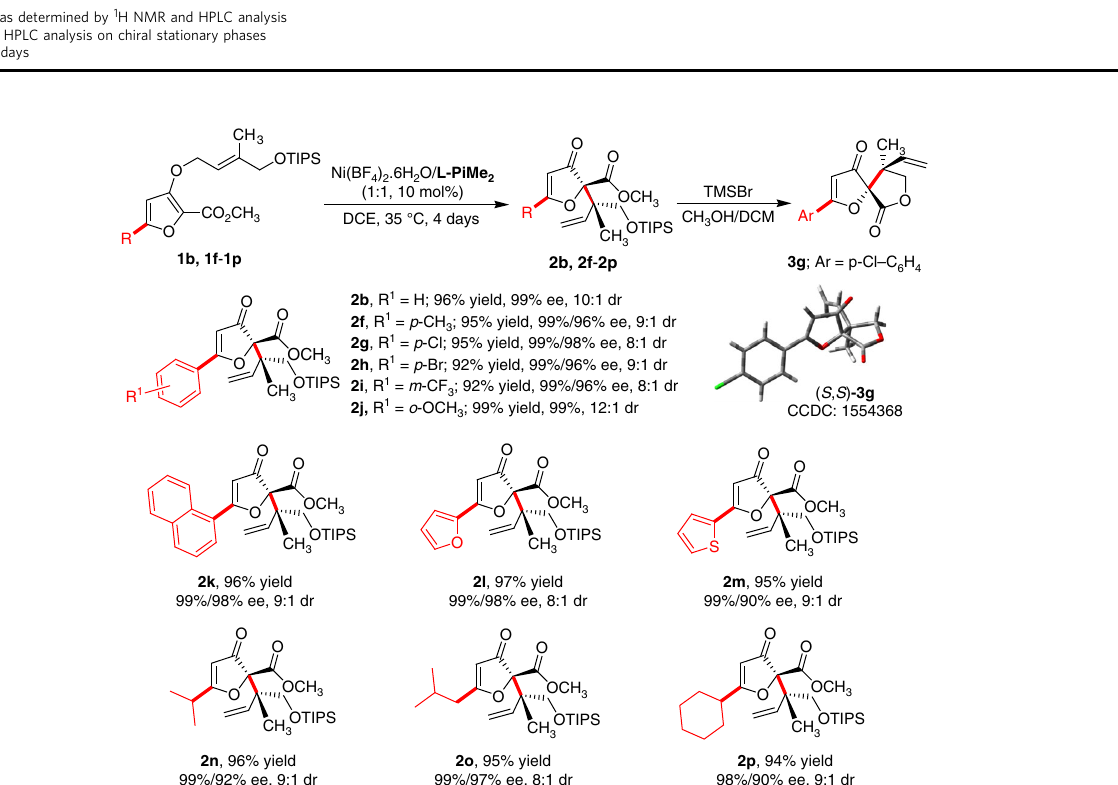
Fig. 2 Substrate scope with variations at the furan unit. Unless otherwise noted, the reactions were performed with 1, Ni(BF 4 ) 2 · 6H 2 O/L-PiMe 2 (1:1, 10mol%), in DCE at 35°C for 4 days. Isolated yield. The dr value was determined by 1 H NMR and HPLC analysis. The ee value was determined by HPLC analysis on chiral stationary phases. The reaction of 2b and 2k were scaled up to 1.0mmol. The reaction of 2n-2p were performed at 35°C for 8